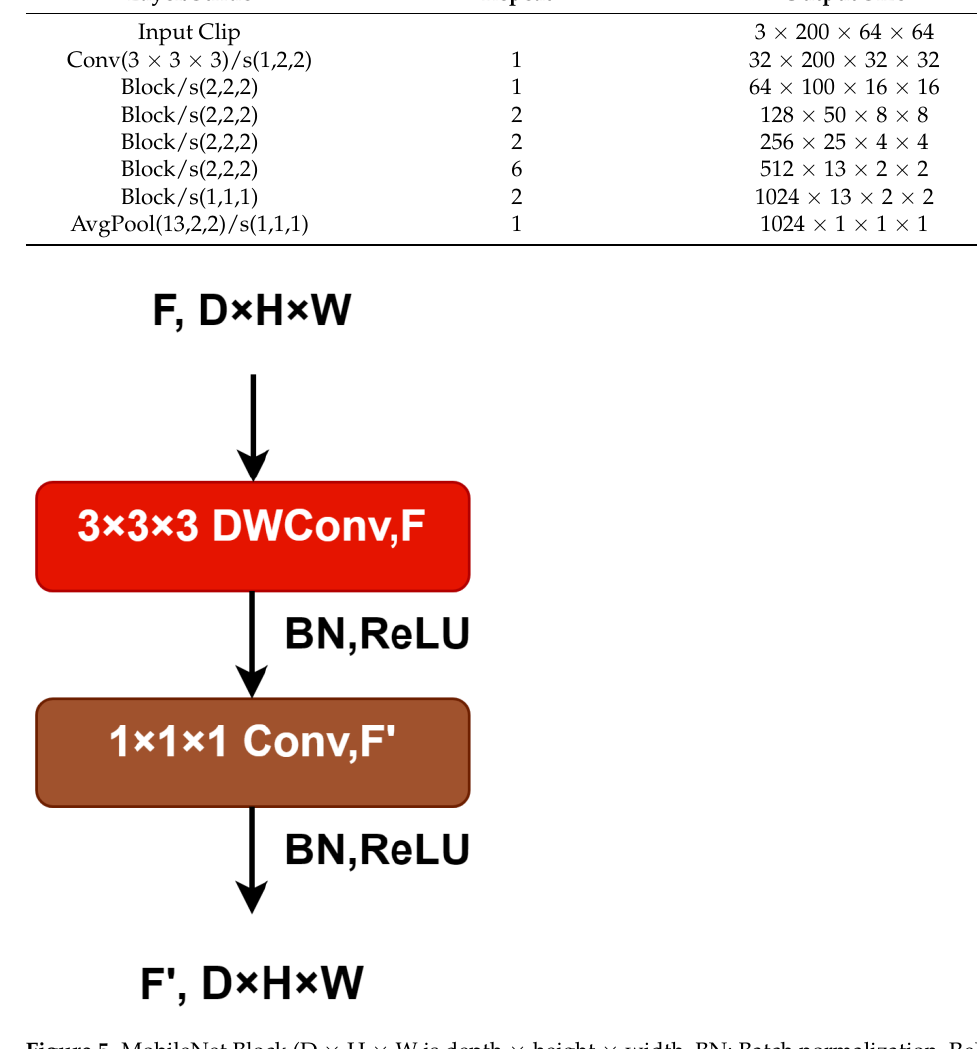
Table 1. 3D-MobileNet architecture.